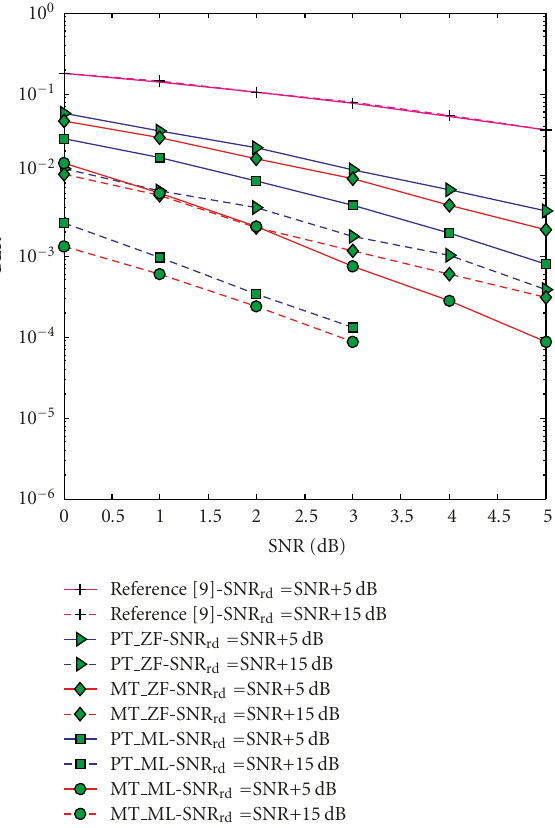
Figure 11: BER versus SNR with di ff erent relay destination channel qualities, SNR in = SNR + 10 dB.